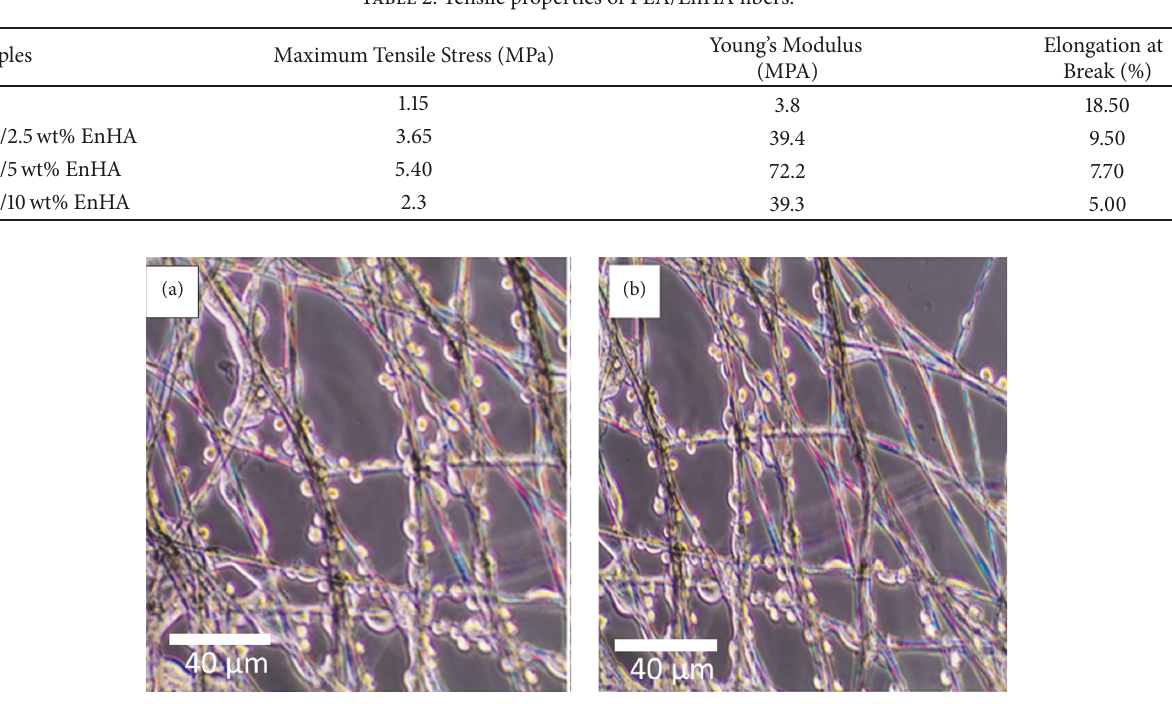
Figure 6: Optical microscope images of ATCC CRL 11372 osteoblast cells adherent to (a) PLA and (b) PLA/5wt%